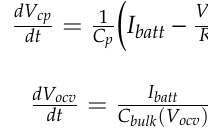
Figure 7. Circuital simulation scheme. Data from a real installation was used to establish the current consumption and generation waveforms. The installation has a DC consumption of 3 A at 24 V, so P cons = 72 W, and it has 700 W PK